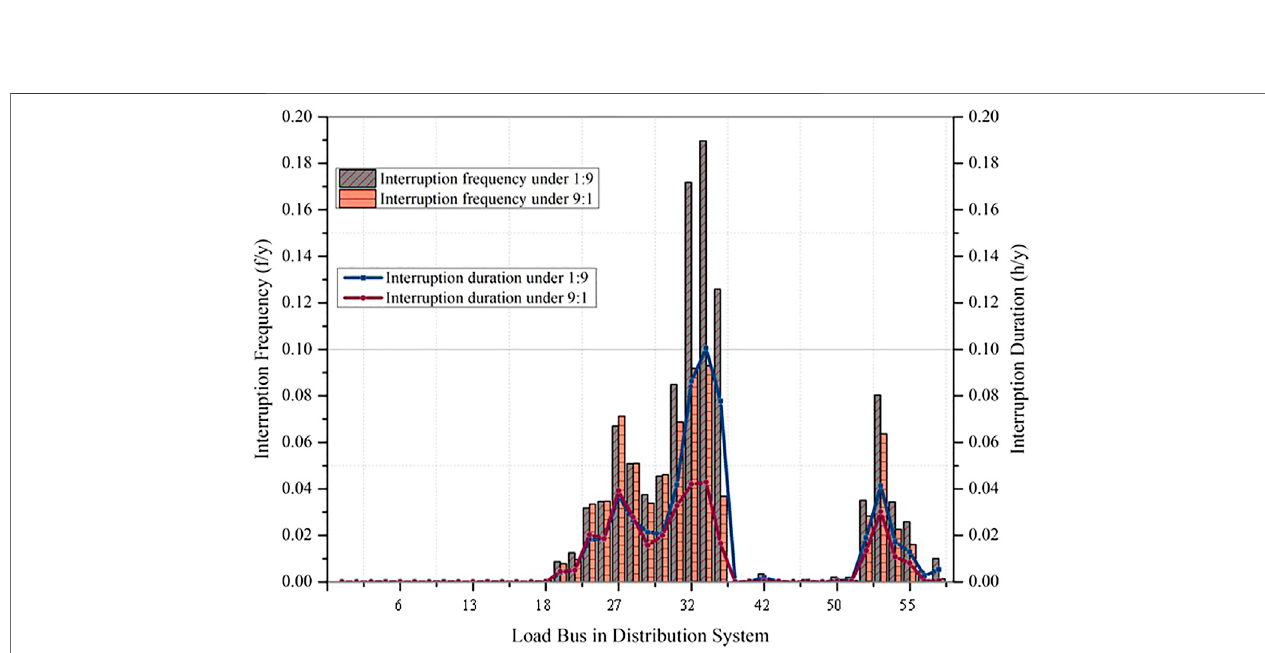
FIGURE 10 | The reliability index POCCE based on a different ratio of trip chain.